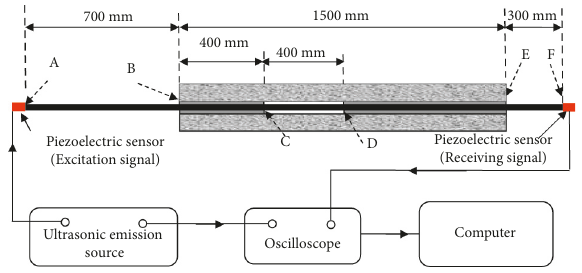
Figure 1: Grouted rock bolt systems model with one bond